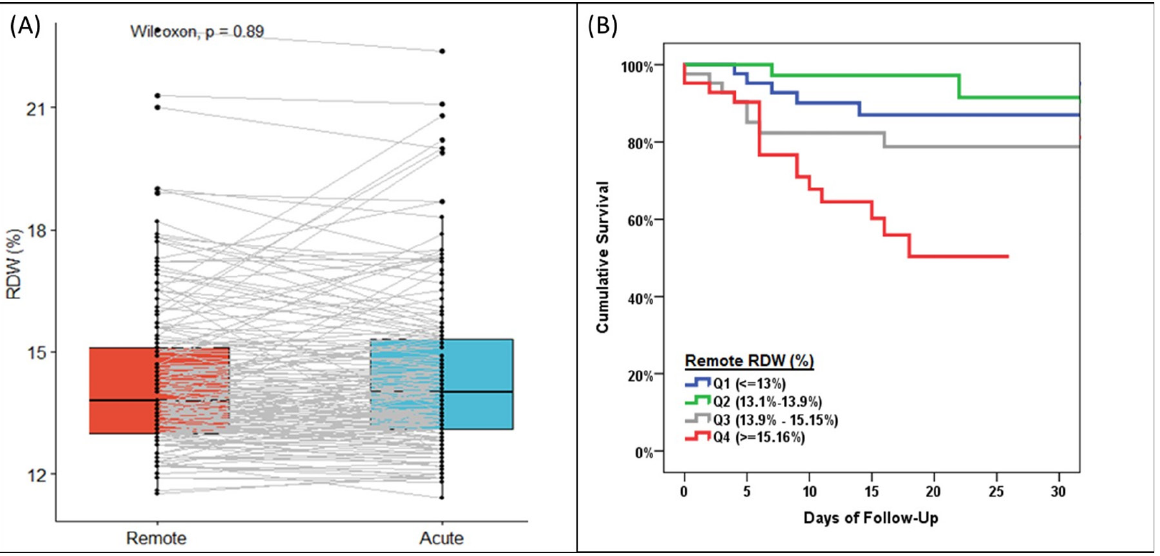
Figure 3. Remote RDW Is Associated With Acute RDW and Mortality (A) Change in RDW (remote to acute) in COVID-19 infected patients, (B) Kaplan-Meier test of mortality in COVID-19